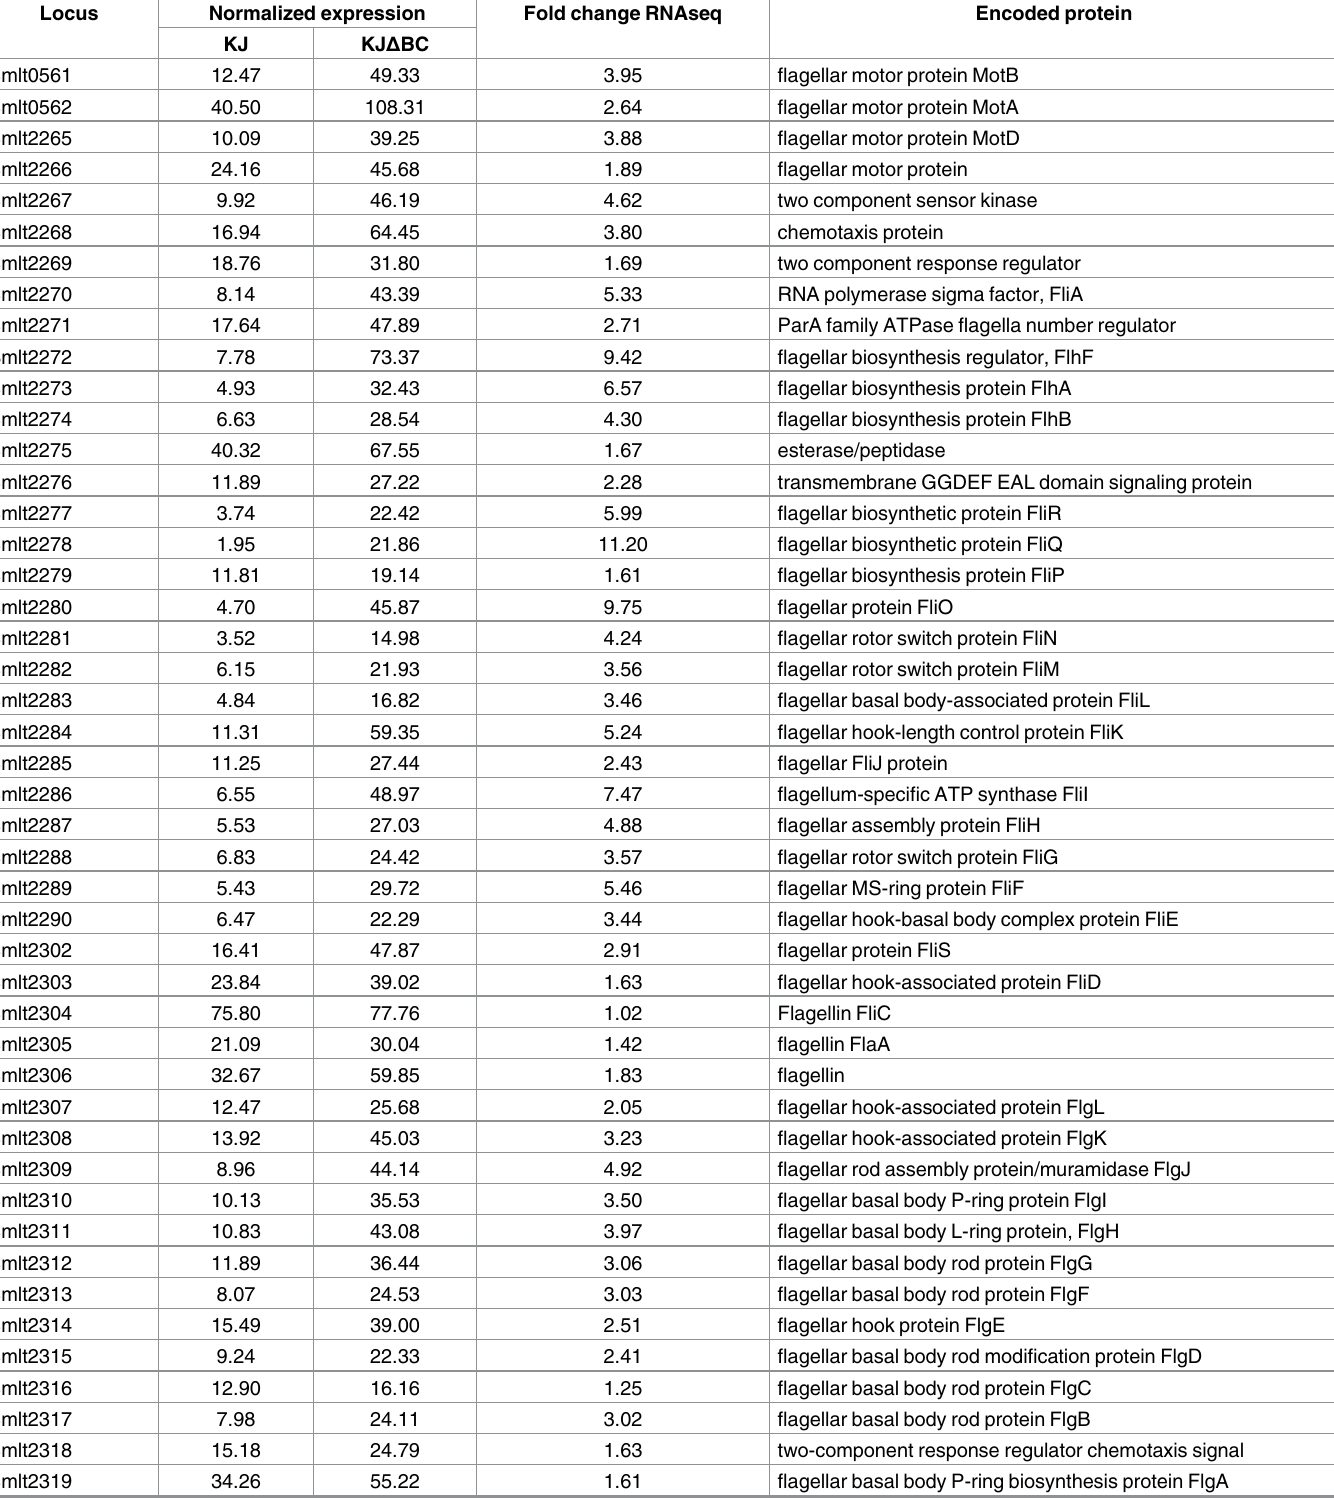
Table 1. Flagella-associated genes differently expressedin S . maltophilia KJ and KJ Δ BCcells.